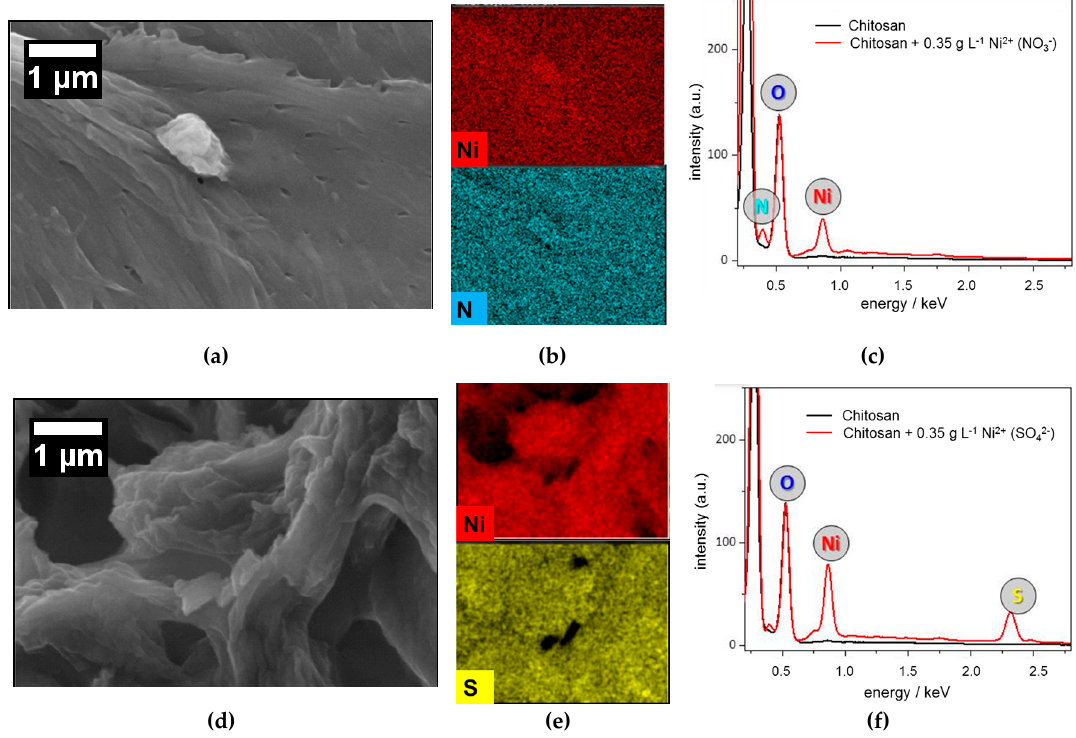
Figure 7. SEM micrographs of the surfaces of chitosan flakes, ( a ) after adsorption of nickel from nickel nitrate solution with ( b ) the corresponding elemental distribution images of nickel and nitrogen and; ( d ) after adsorption of nickel from nickel sulfate solution with ( e ) the corresponding elemental distribution images of nickel and sulfate; ( c ) and ( f ) show the EDX spectra of natural chitosan surface and chitosan surface after adsorption of nickel from nickel sulfate and nitrate solution, respectively. In both cases initial concentration of nickel was 350 mg·L − 1 and contact time amounted to 24 h.